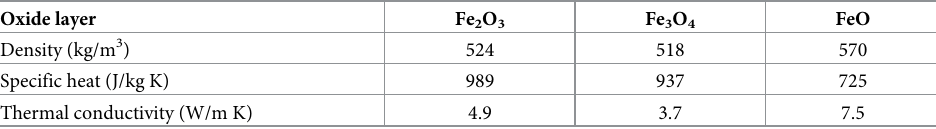
Table 1. Thermophysical properties of the three oxide